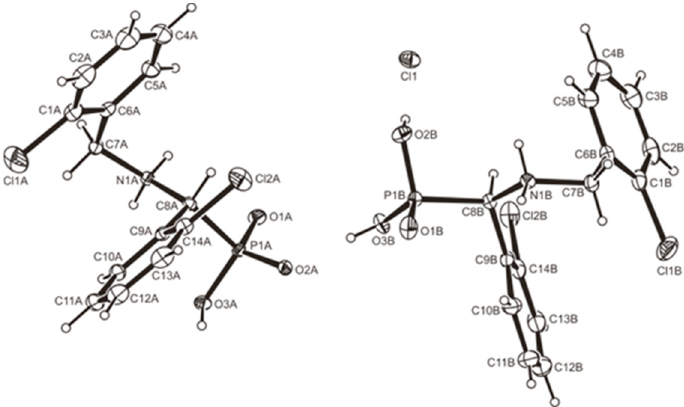
Figure 1. The crystal structure of molecule 6d . Displacement ellipsoids are drawn at a 20% probability level.